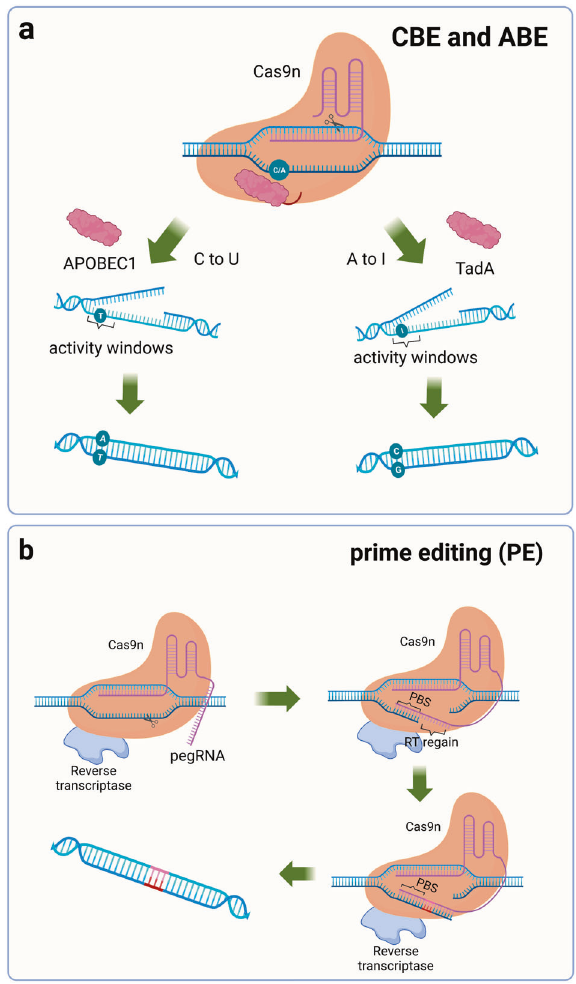
Fig. 4 Schematic diagram of the single-base substitution tool. a Fusion of Cas9n with adenosine deaminase or cytidine deaminase enables the introduction of point mutations in the genome, APOBEC1 induces a C to U mutation, and TadA induces an A to I mutation. b PE contains a 30 bp segment of pegRNA, including the PBS sequence and RT region. PBS binds to the DNA strand and synthesizes the complementary strand of the RT region in the presence of reverse transcriptase. PBS primer binding site, RT reverse transcriptase, pegRNA prime editing guide RNA. (Figure was created with